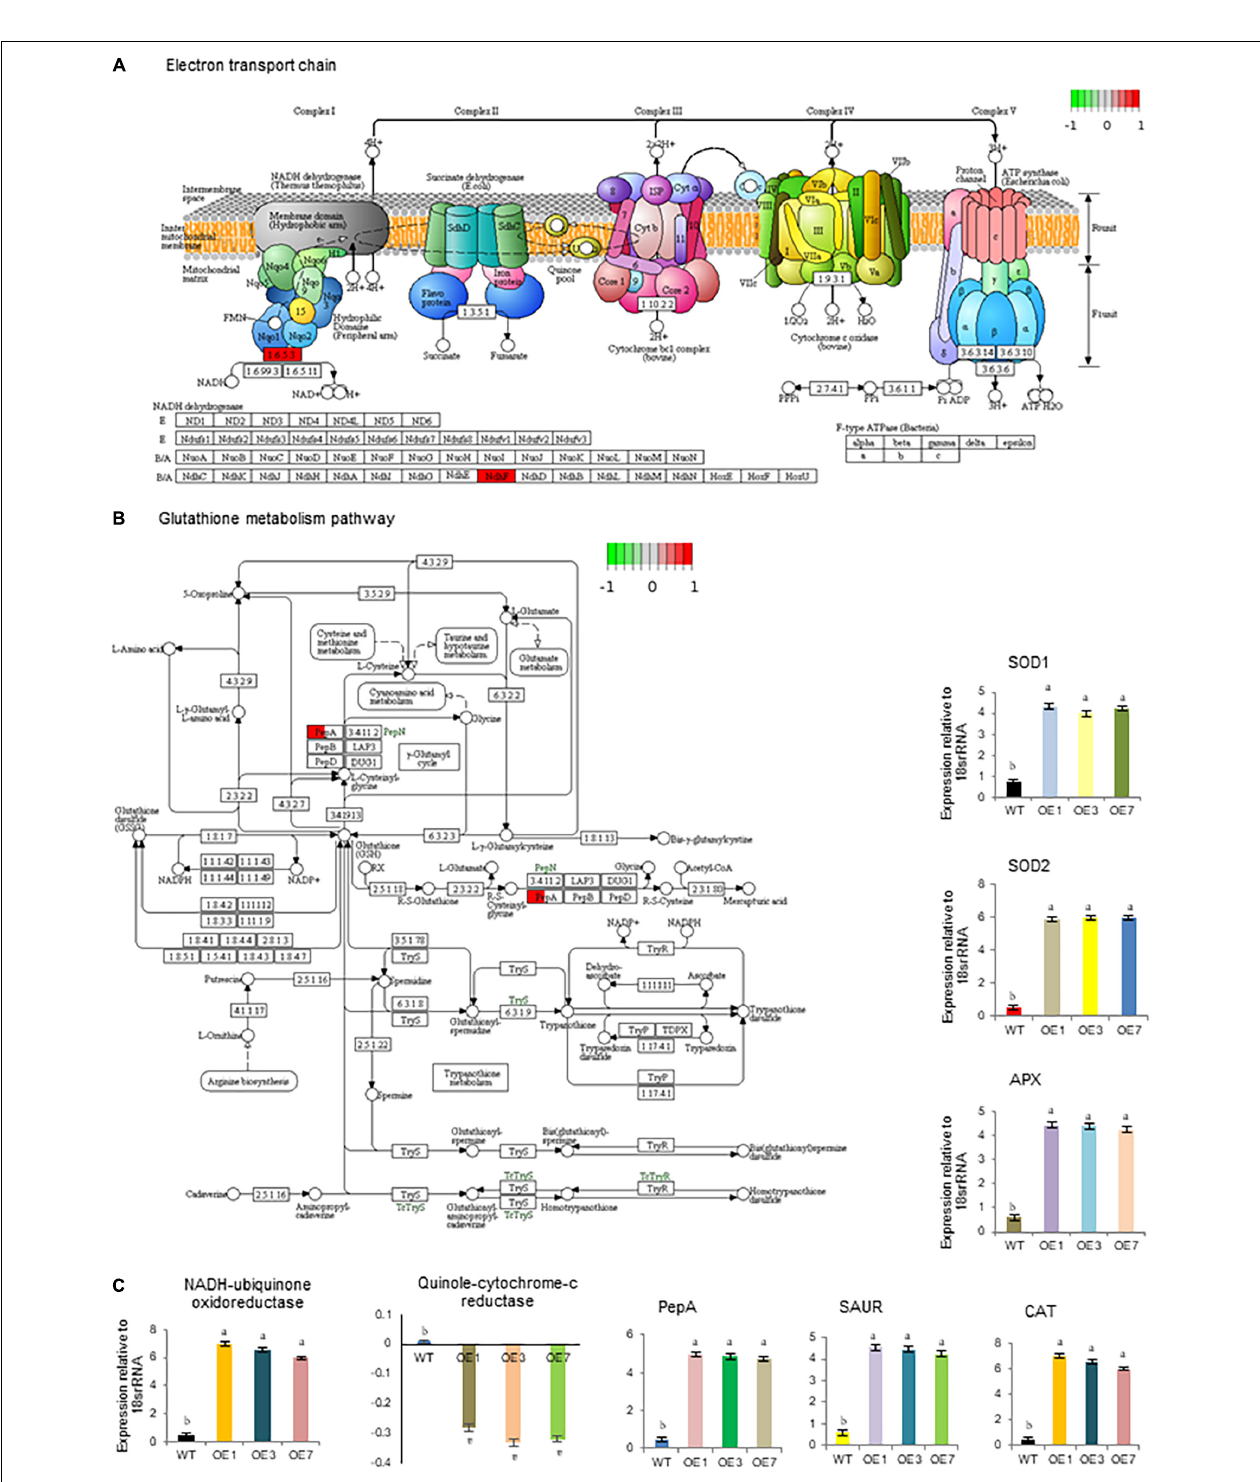
FIGURE 6 | Important biological pathways significantly affected SmHSP24.1 overexpressed transgenic (OE) plants as compared with wild-type (WT). (A) First protein complex NADH-ubiquinone oxidoreductase significantly affected the electron transport chain (ETC). (B) PepA (aminopeptidase) positively affected the Glutathione metabolism pathway. (C) Time-dependent relative quantitative RT-PCR validation of some selected genes ( NADH-ubiquinone oxidoreductase , Quinol-cytochrome c- oxidoreductase , PepA , SOD1 , SOD2 , CAT , APX, and SAUR ) highly affected in these pathways. mRNA level was normalized with respect to housekeeping gene 18srRNA and fold change in expression was calculated as compared with WT sample. RT-qPCR data are M ± SD ( n = 3). The letters a, b, c, and others indicate significant differences between different lines ( P < 0.05).